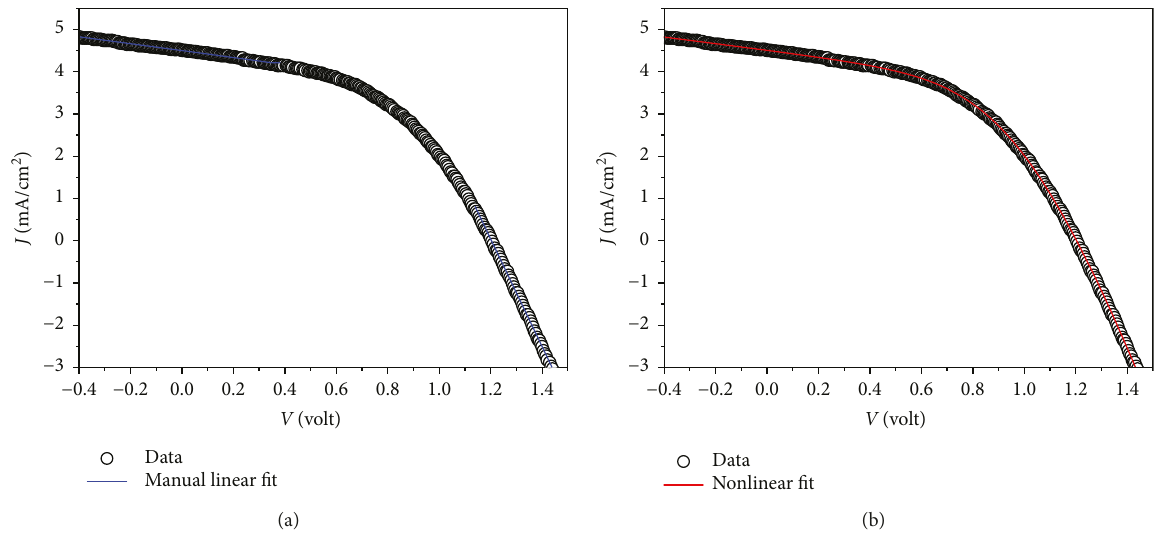
Figure 5: I-V curve fi t on an organic solar cell based on ITO/CuPc/PTCBI/Ag: (a) manual method and (b) nonlinear curve fi